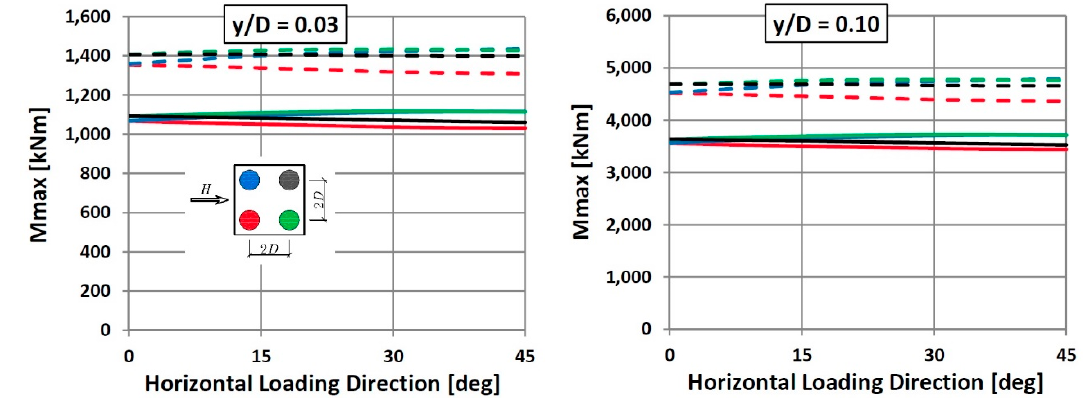
Figure 14. Maximum bending moments for square 2 × 2 pile group ( s x = 2 D , s y = 2 D ). Different colors denote piles inside the pile group. Full lines—loose sand; dashed lines—dense sand.